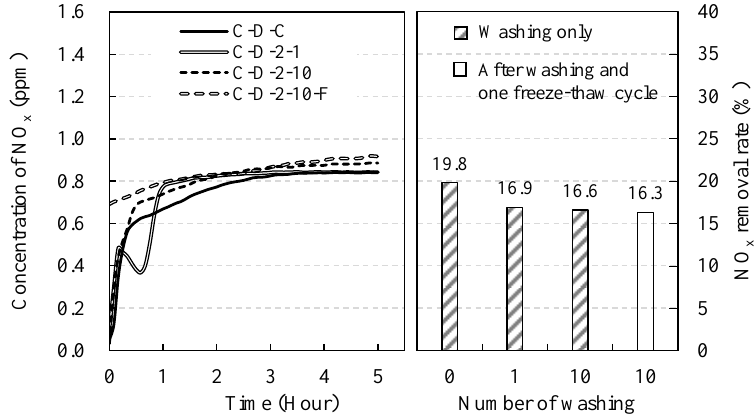
Figure 11. NO x removal rate of textile fabrics coated with coconut shell activated carbon after exposure to external environmental conditions.